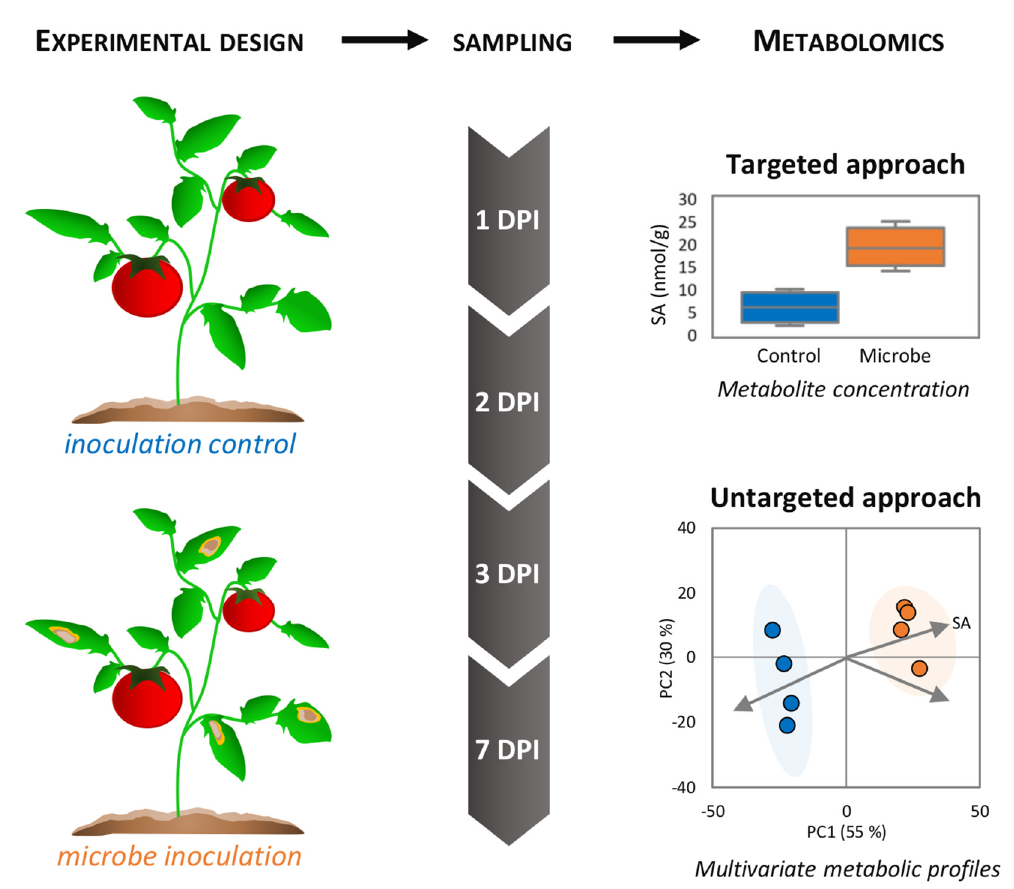
Figure 1. Experimental design in phytopathological metabolomics. Plant tissues (here, tomato leaves) are inoculated without (i.e., mock) or with the pathogenic microbe (here, a fungus causing necrotic lesions), or exposed to other biotic challenges (e.g., elicitors). Subsequent sampling of control and infected material is usually performed following a time course expressed as day post-inoculation (DPI), sample metabolism is quenched by snap-freezing in liquid nitrogen, followed by storage at − 80 °C until metabolomic analyses. Targeted metabolomics will allow measuring the levels of specific compounds (here, the defense hormone salicylate, SA). On the other hand, untargeted approaches can evaluate the global impacts of the microbial interactions on metabolic profiles using multivariate statistics (here, a principal component analysis score plot), where the best discriminators could be revealed (represented as arrows, e.g., SA).